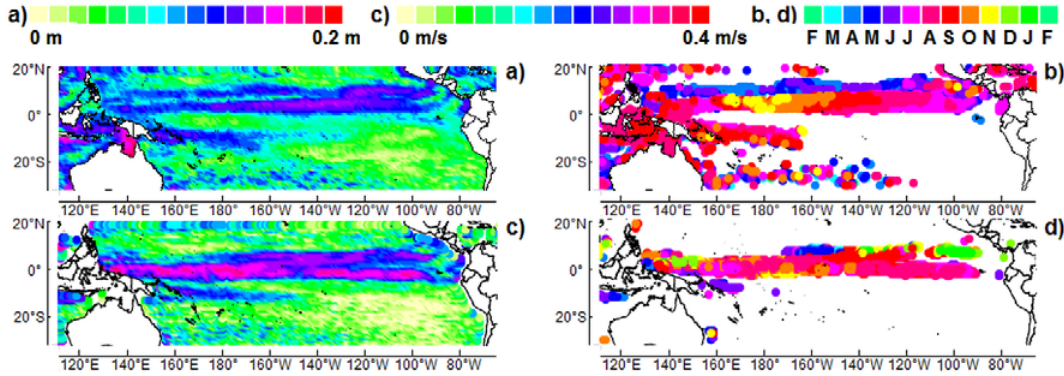
Figure 1. Amplitude (left) and phase (right) relative to August 1999, averaged in the 8–16 month band of: ( a , b ) antinodes, ( c , d ) zonal velocity u (facing east) at the nodes. The choice of colors to represent the phase in ( b , d ) reflects the periodicity of the observed phenomenon; the amplitude remains nearly the same in February, whatever the year. The sea surface height (SSH) is provided by the French CNES (Centre National d’Etudes Spatiales): www.aviso.oceanobs.com. The geostrophic surface current velocity field (SCV) is obtained through the OSCAR (Ocean Surface Current Analyses: Real time) program and provided by the NOAA (National Oceanic and Atmospheric Administration):